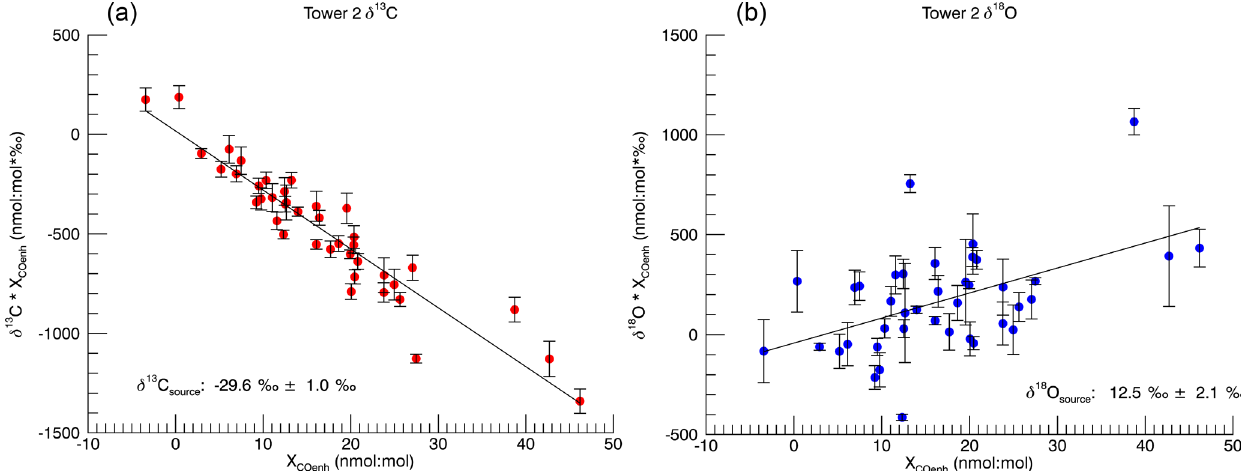
Figure 2. Indianapolis Miller–Tans plots for late spring through summer (May, June, July, August, September). The error bars represent the propagated error for the calculation of the enhancements (see text for